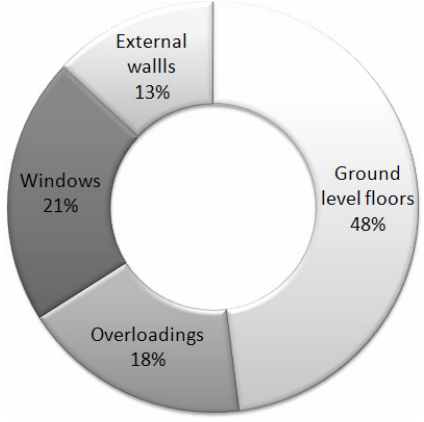
Fig. 1. Average annual losses of heat in residential buildings of Lithuania